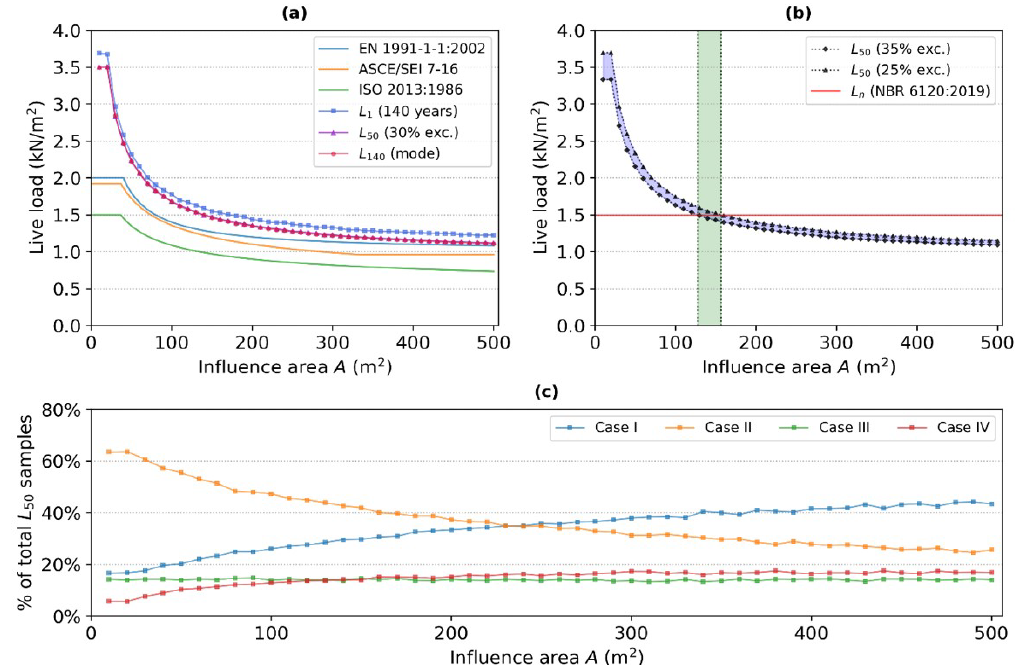
Figure 8. Simulated total live load for residential